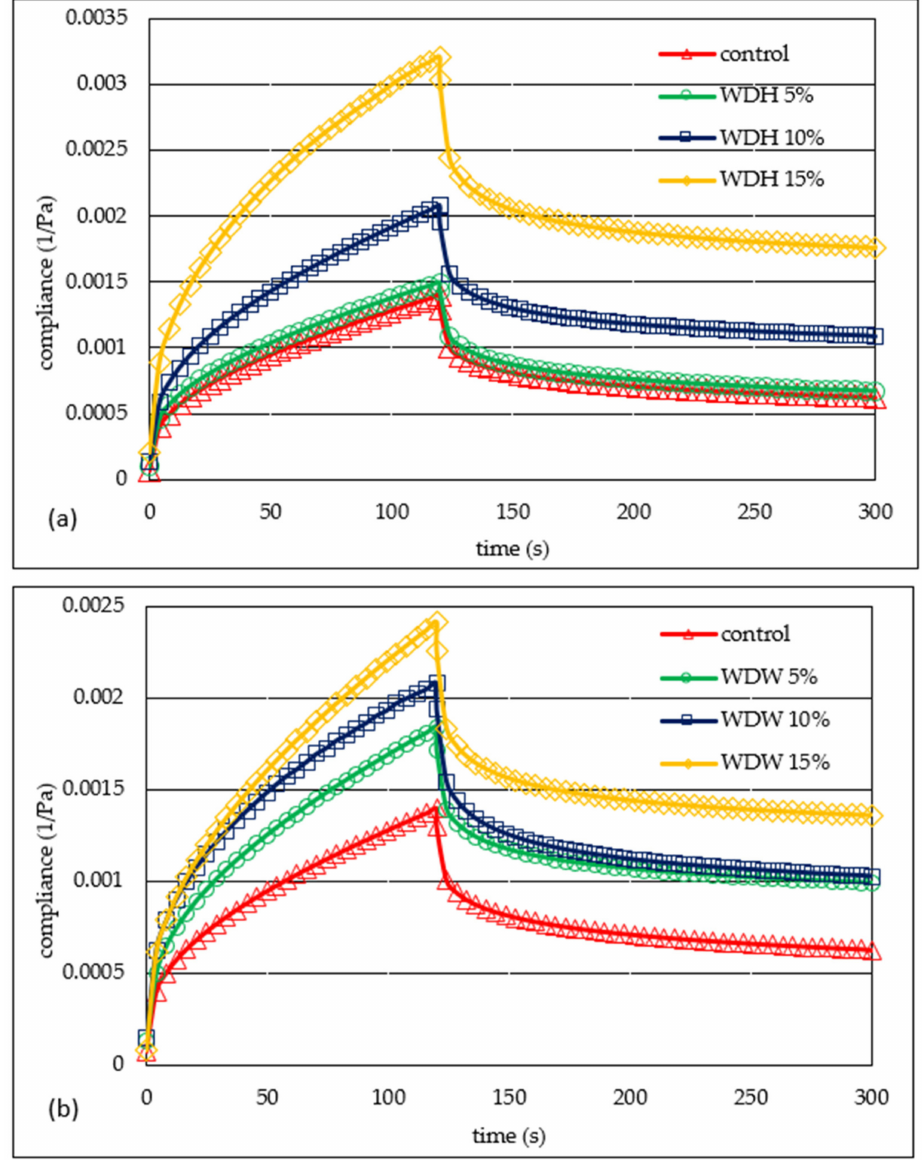
Figure 4. Creep and recovery curves of the control sample and doughs with hazelnut ( a ) or walnut ( b )